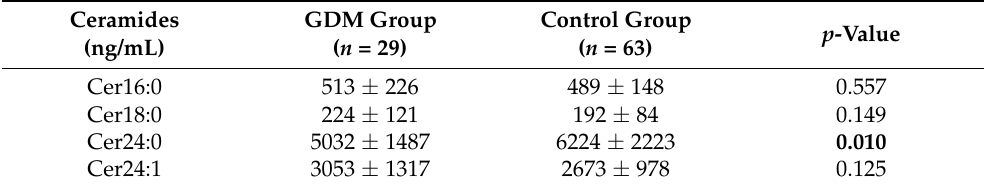
Table 2. Mean ceramide concentrations (ng/mL) ± standard deviation in GDM and control groups and p